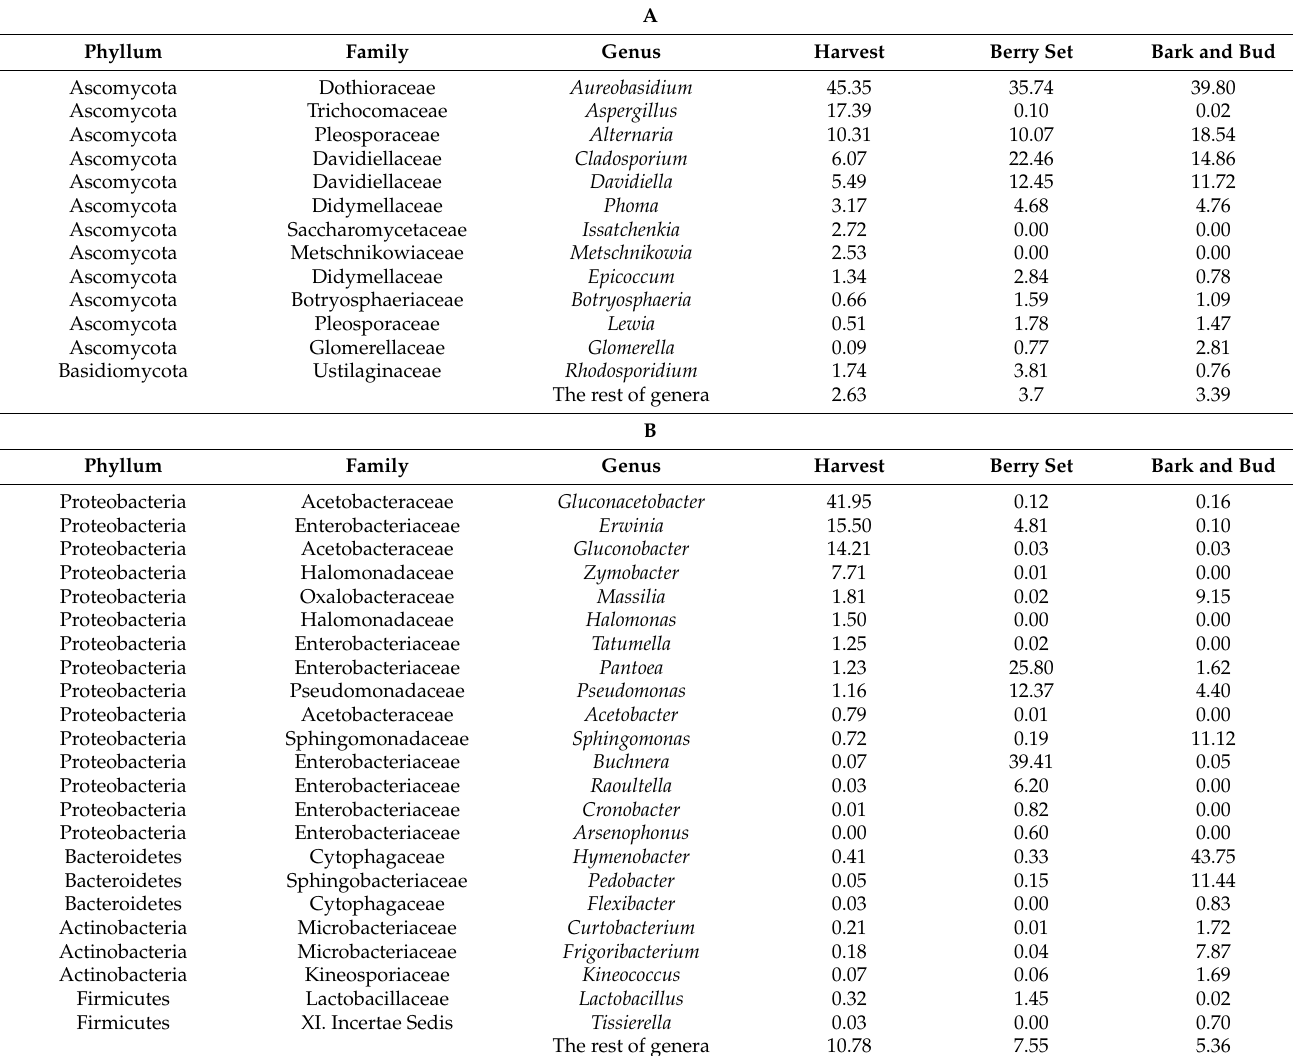
Table 2. Relative abundance of ( A ) fungal and ( B ) bacterial genera with their percentages detected among the three phenological